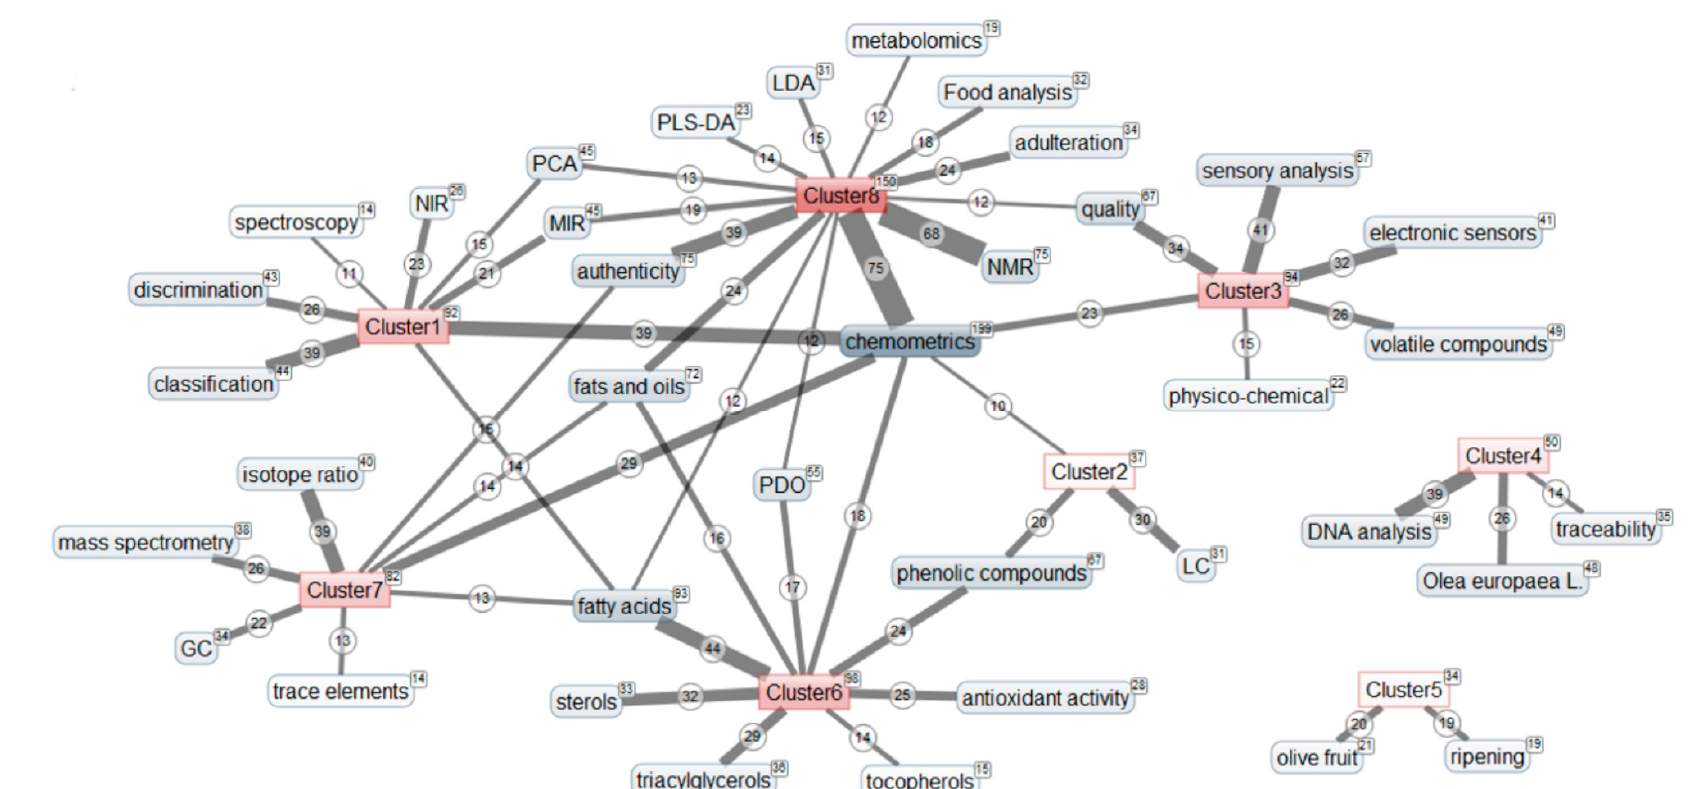
Figure 3. Network of the main keywords associated at least ten times with one or more of the thematic clusters ( □ : total number of articles in the corpus associated with this keyword or cluster, ○ : number of articles associated with this keyword in the specified cluster). GC: gas chromatography ; LC: liquid chromatography ; MIR: mid-infrared; NIR: Near-infrared; NMR: Nuclear Magnetic Resonance ; PDO: protected designation of origin; PCA: principal component analysis ;LDA: linear discriminant analysis; PLS-DA: partial least square-discriminant analysis.